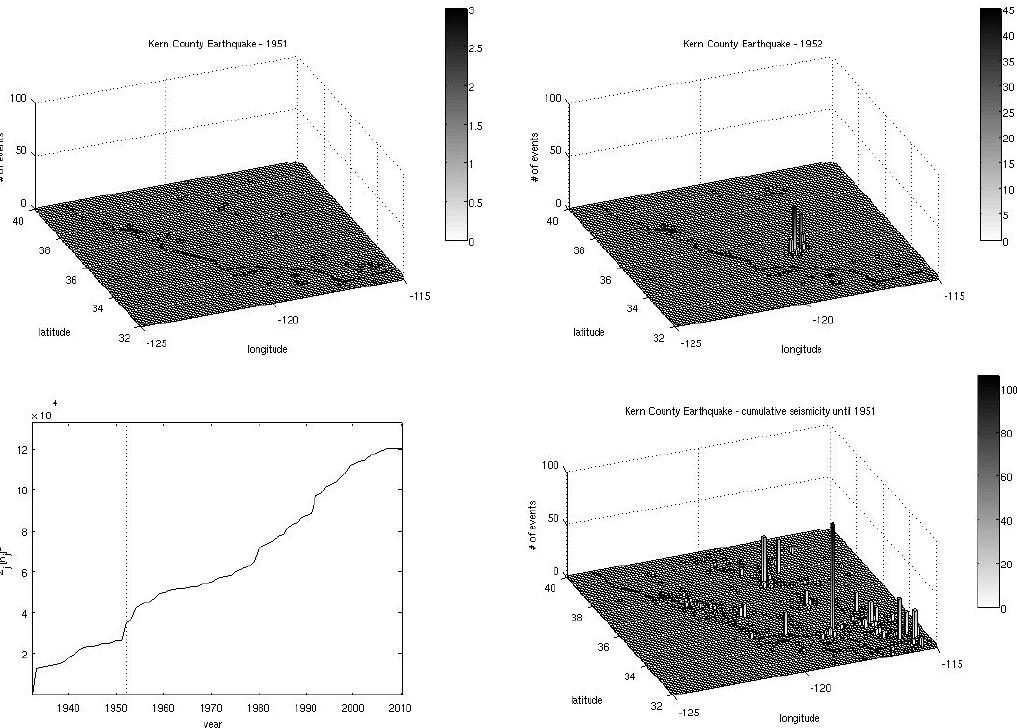
Fig. 4. Distribution of events before the 1952 Kern County earthquake before the mainshock (top left), after the mainshock (top right) and up until the mainshock since 1932 (bottom right). The approximation in Eq. (4) with the time of occurrence of the 1952 Kern County event as the dashed line are also plotted (bottom